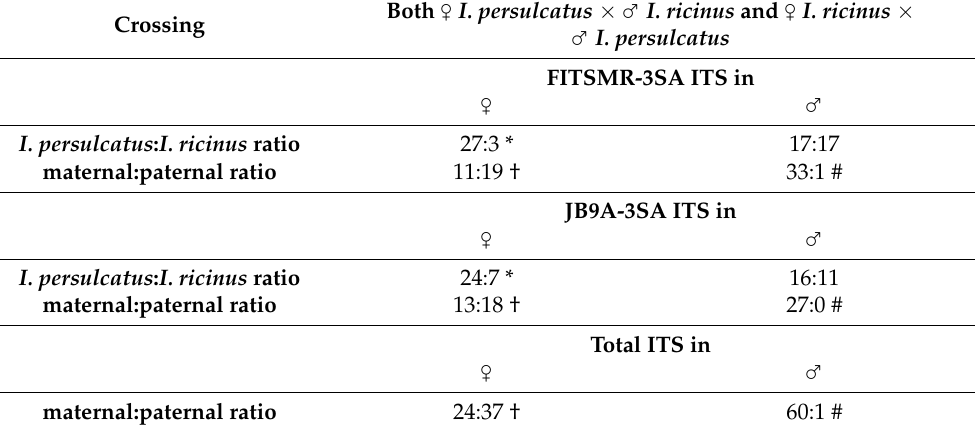
Table 5. Ratios of molecular clones of the ITS2 region obtained for hybrid ticks.